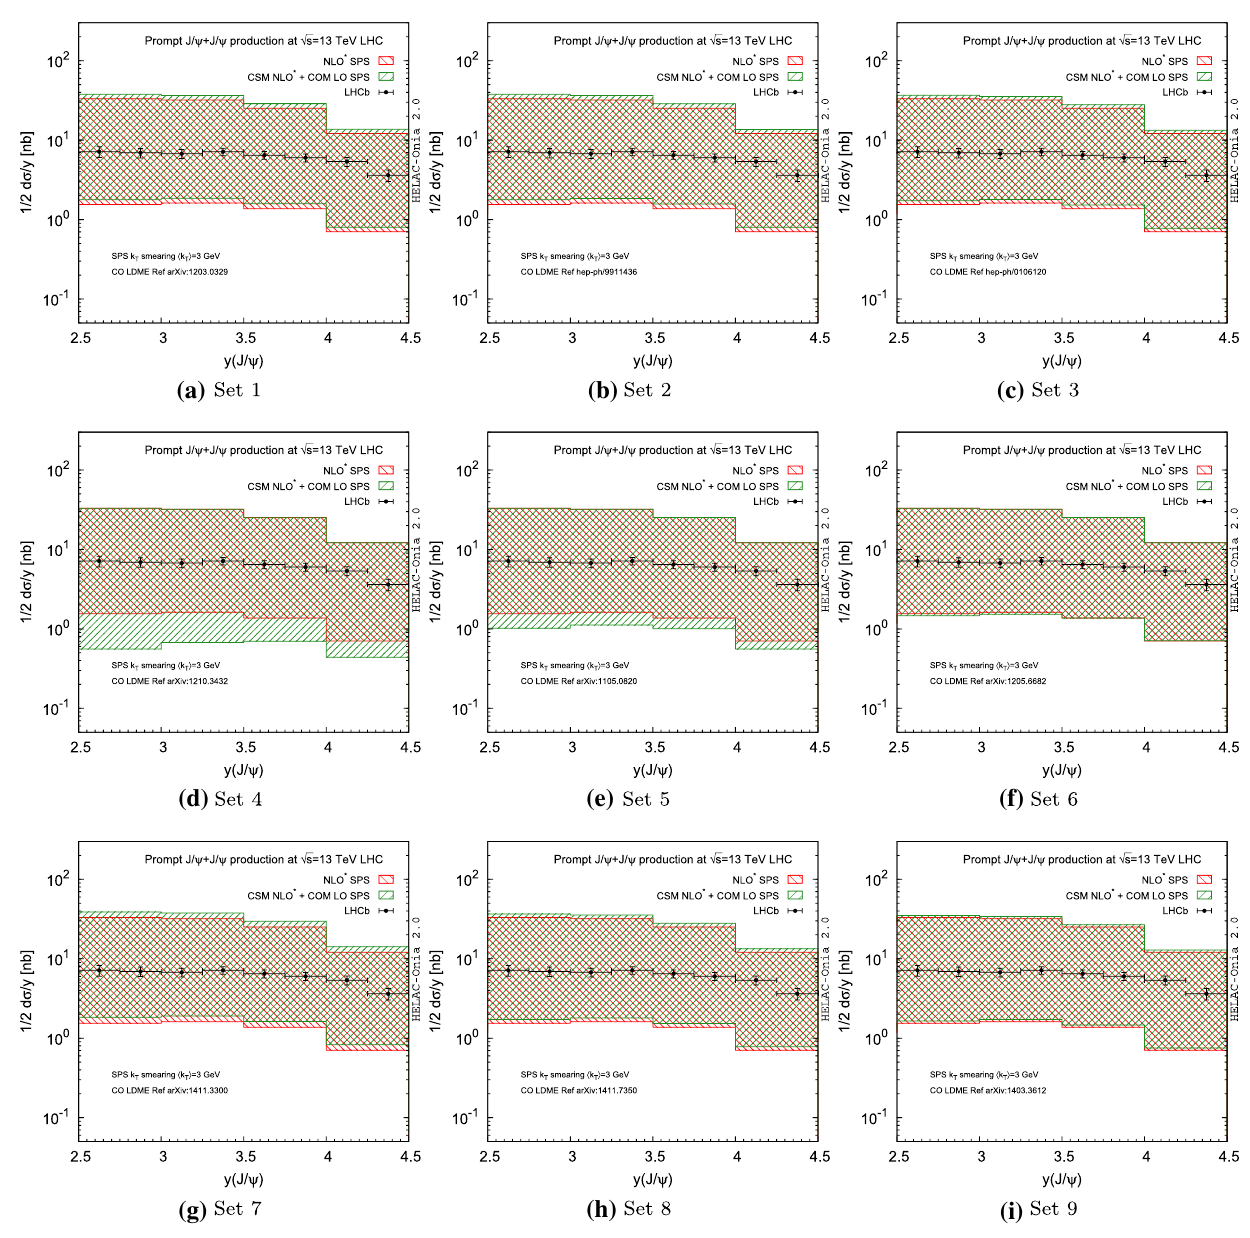
Fig. 17 y ( J /ψ) distributions via SPS NLO (cid:11) CS and LO CO in the LHCb acceptance at